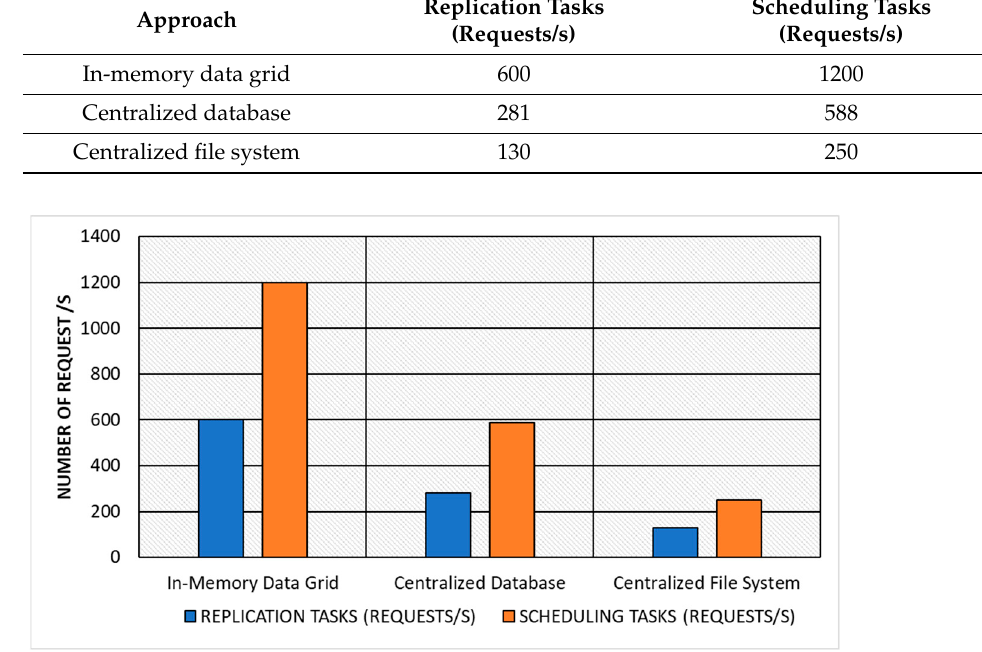
Figure 6. The throughput average of replication and scheduling.